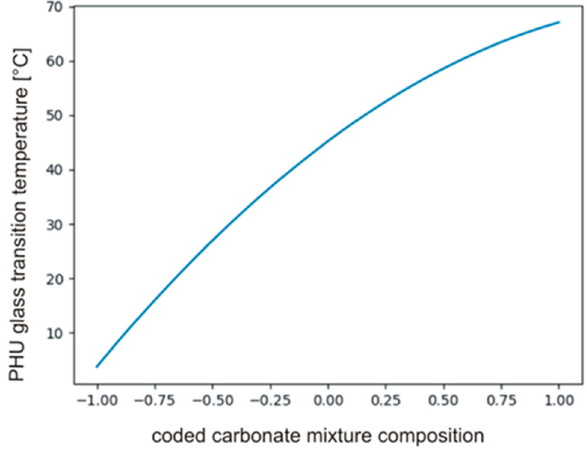
Figure 9. The plot of the function described by Equation (17).